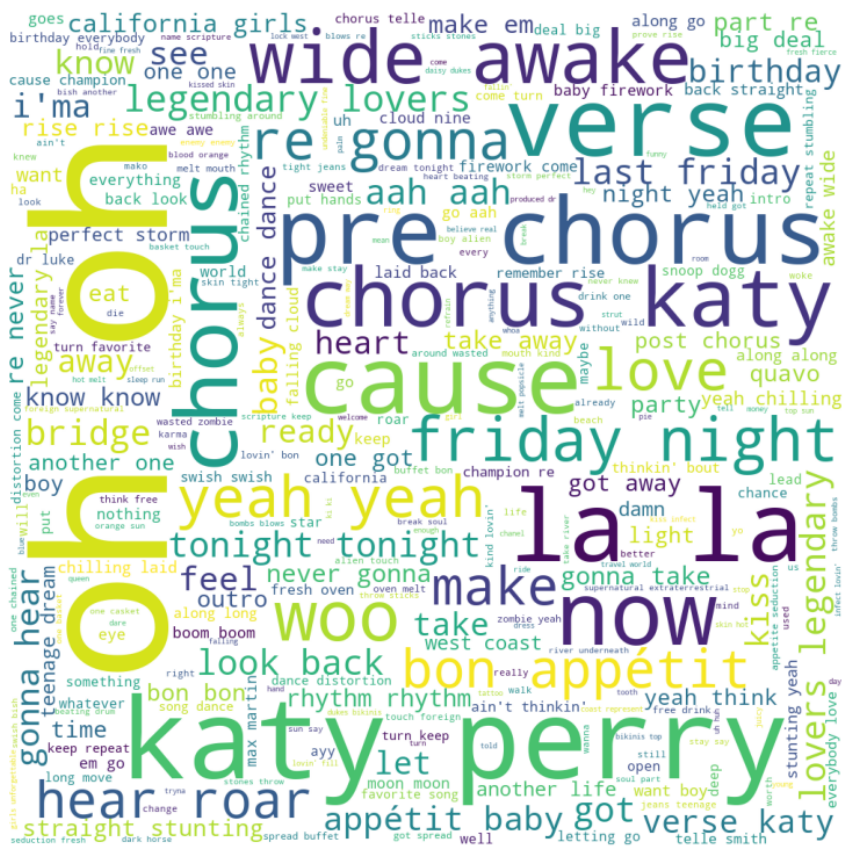
Figure 8. Word cloud representing the frequency of important words in the Katy Perry song’s